Question: What does this figure show? Answer in one sentence.
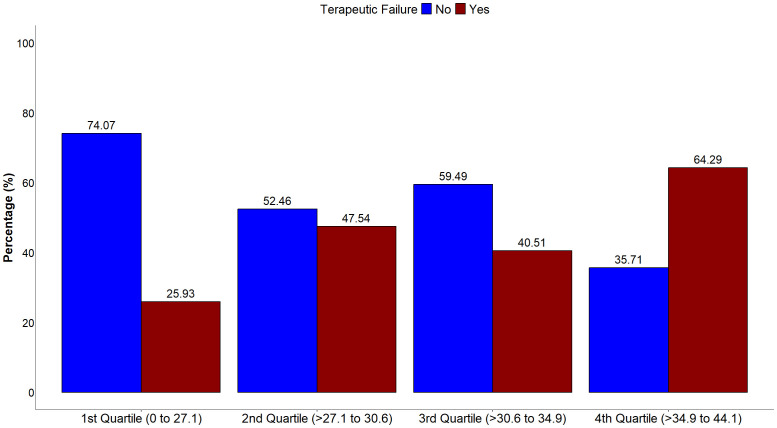
Answer: Distribution of the calculated score divided into quartiles, stratified by the presence or absence of TF.